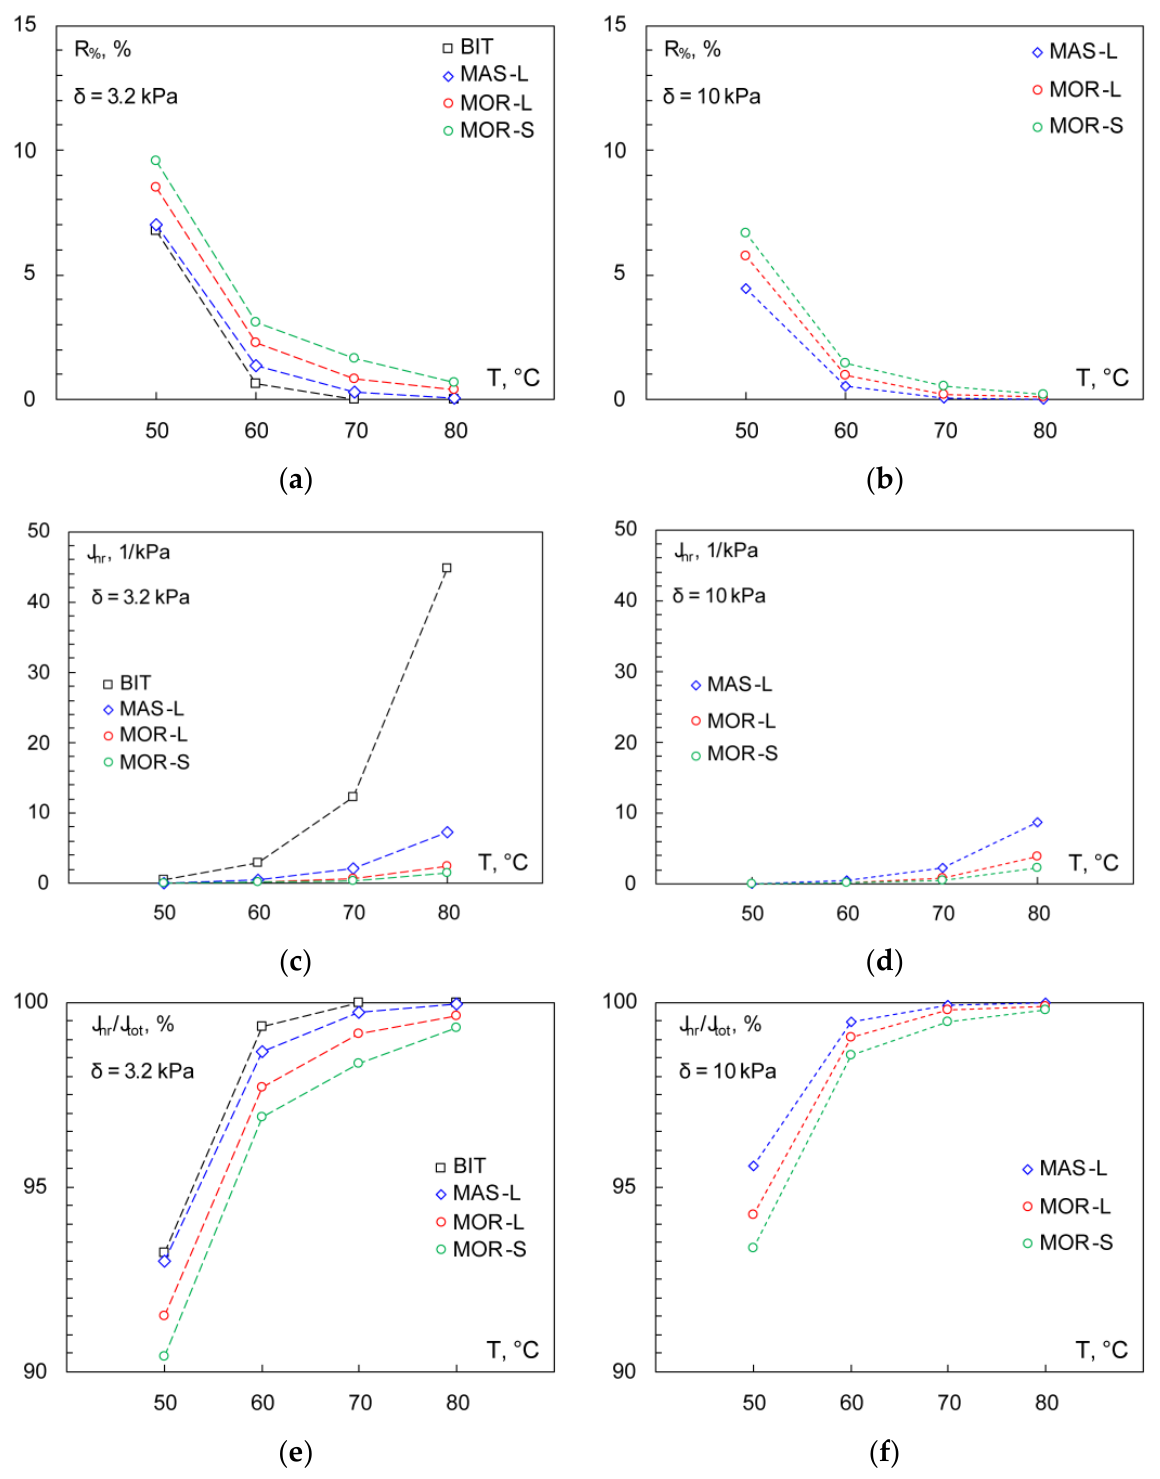
Figure 5. MSCR test results. Percentage recovery R % at 3.2 ( a ) and 10 kPa ( b ); non-recoverable creep compliance J nr at 3.2 ( c ) and 10 kPa ( d ); non-recoverable creep compliance related to total creep compliance J nr / J tot at 3.2 ( e ) and 10 kPa ( f ).